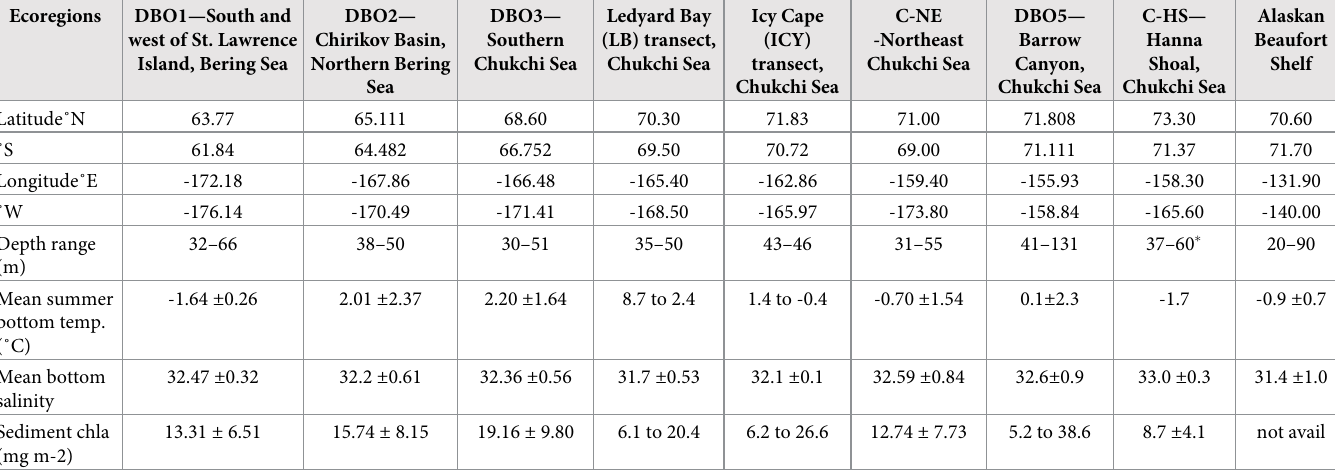
Table 1. Ecoregion names and respective bounding coordinates of sample groups and transects investigated in this study.